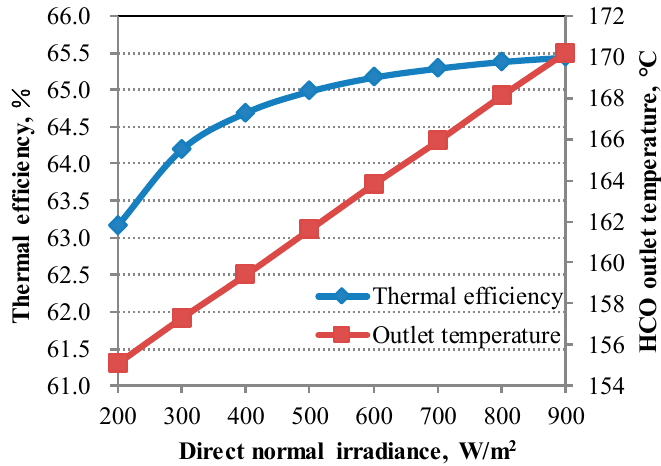
Figure 4. Variations in heat collecting efficiency and heat conducting oil (HCO) outlet temperature of the LS-2 PTC with the different direct normal irradiance (DNI) (the inlet temperature and flow rate of the HCO are 151 °C and 47.8 L/min, respectively).